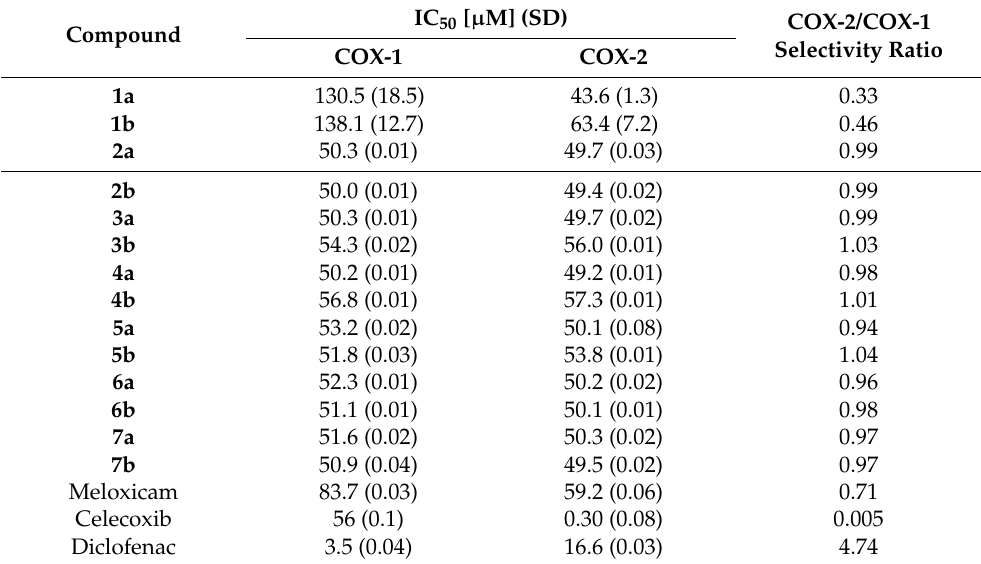
Table 1. IC 50 values determined for COX-1 and COX-2; data are shown as standard deviation